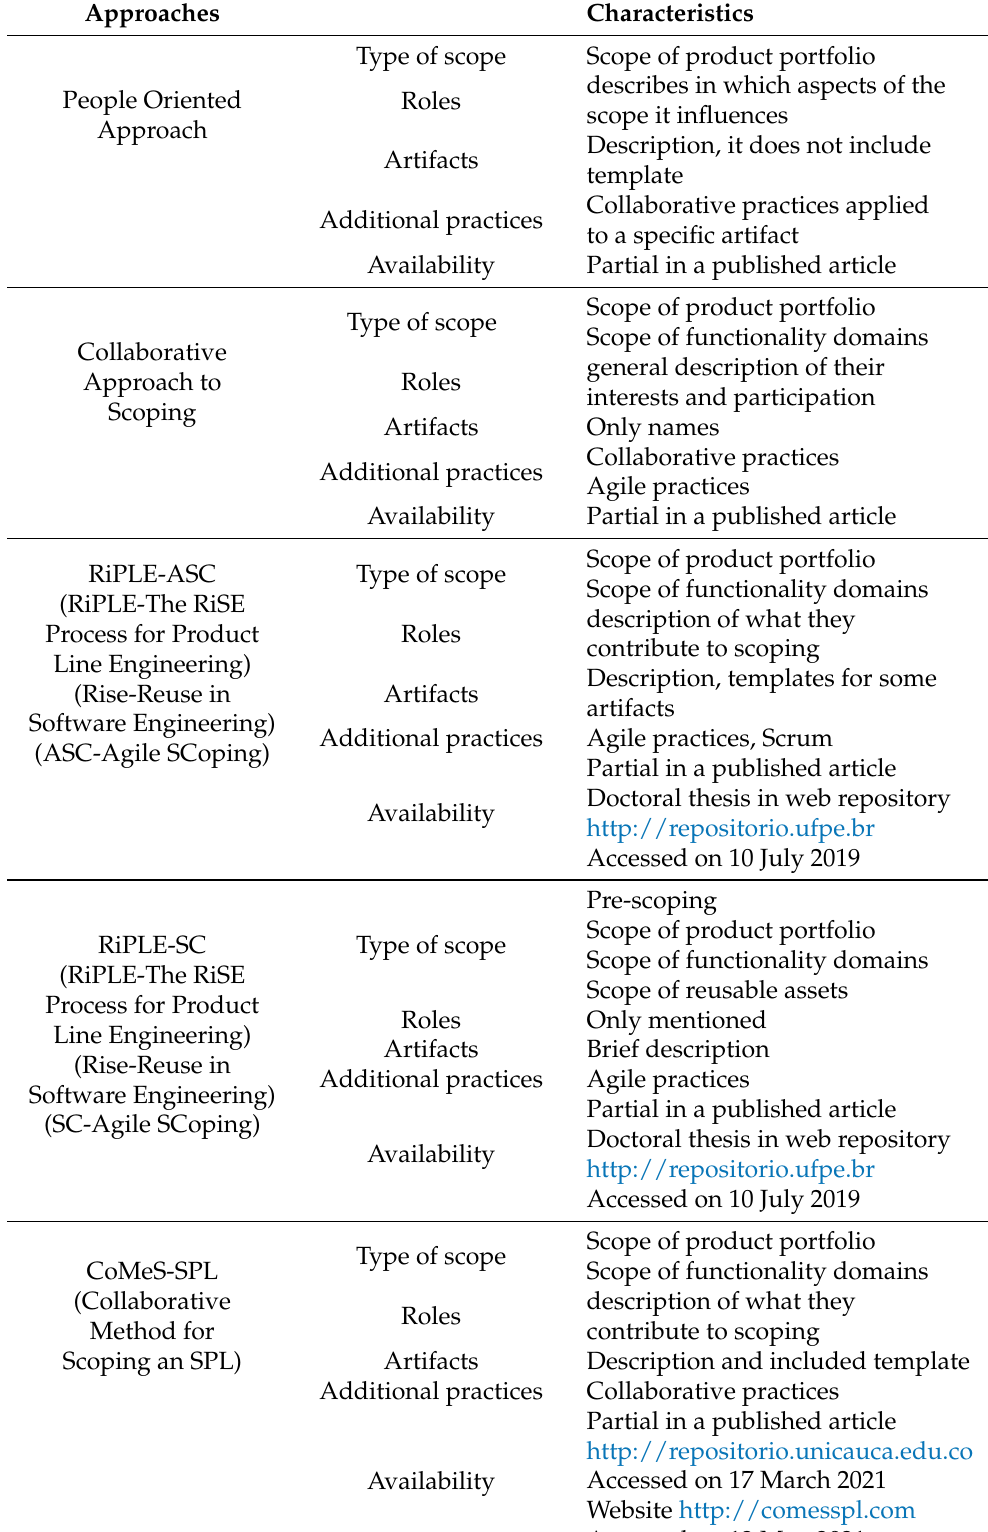
Table 1. Comparison among SPL scoping (Software Product Line Scoping) approaches that consider- ing collaborative